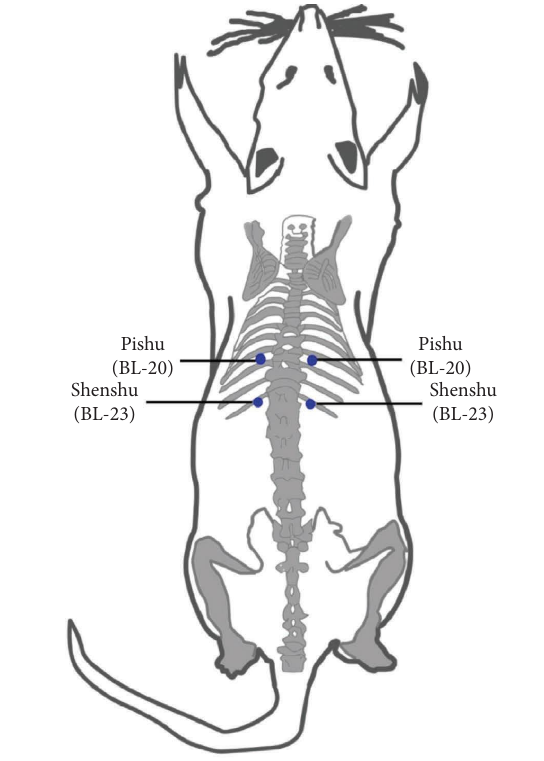
Figure 2: Location of acupuncture points (Pishu, Shenshu) on the backs of mice